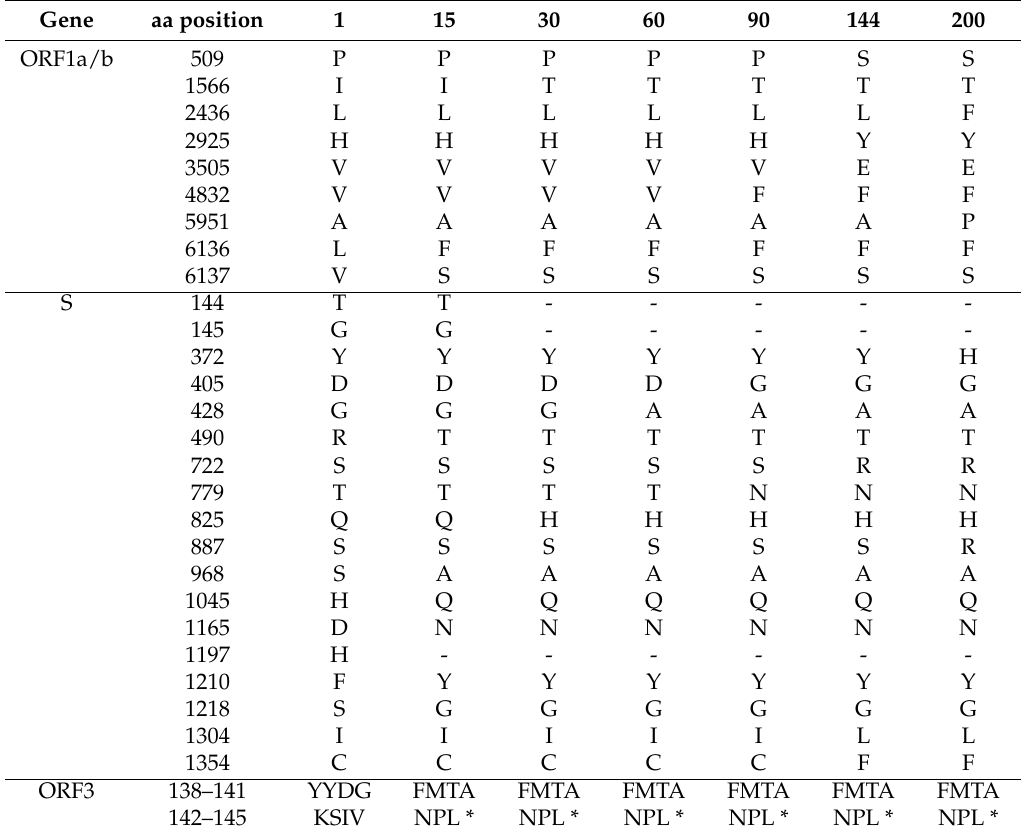
Figure 4. The immunohistochemical (IHC) results were scored by the distribution or extent of positive signal of IHC assay, each data point represents an individual animal in each treatment group, and median values are indicated by horizontal bars. ** p < 0.01. Table 1. The amino acid (aa) variation of non-structural and structural proteins during the serial passage (The mutated amino acids are